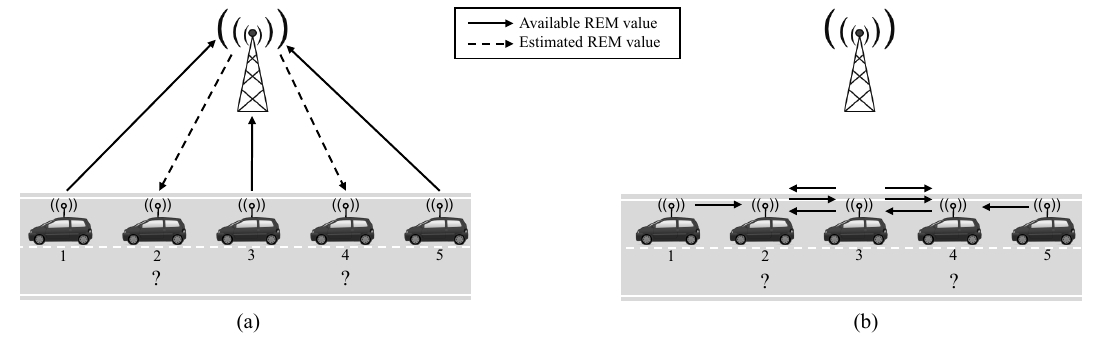
Figure 2. Example of the proposed reconstruction architectures in a platoon of five vehicles. ( a ) Centralized, ( b ) distributed. Vehicles 1, 3 and 5 access actual radio environment map (REM) values, while estimates are needed for vehicles 2 and